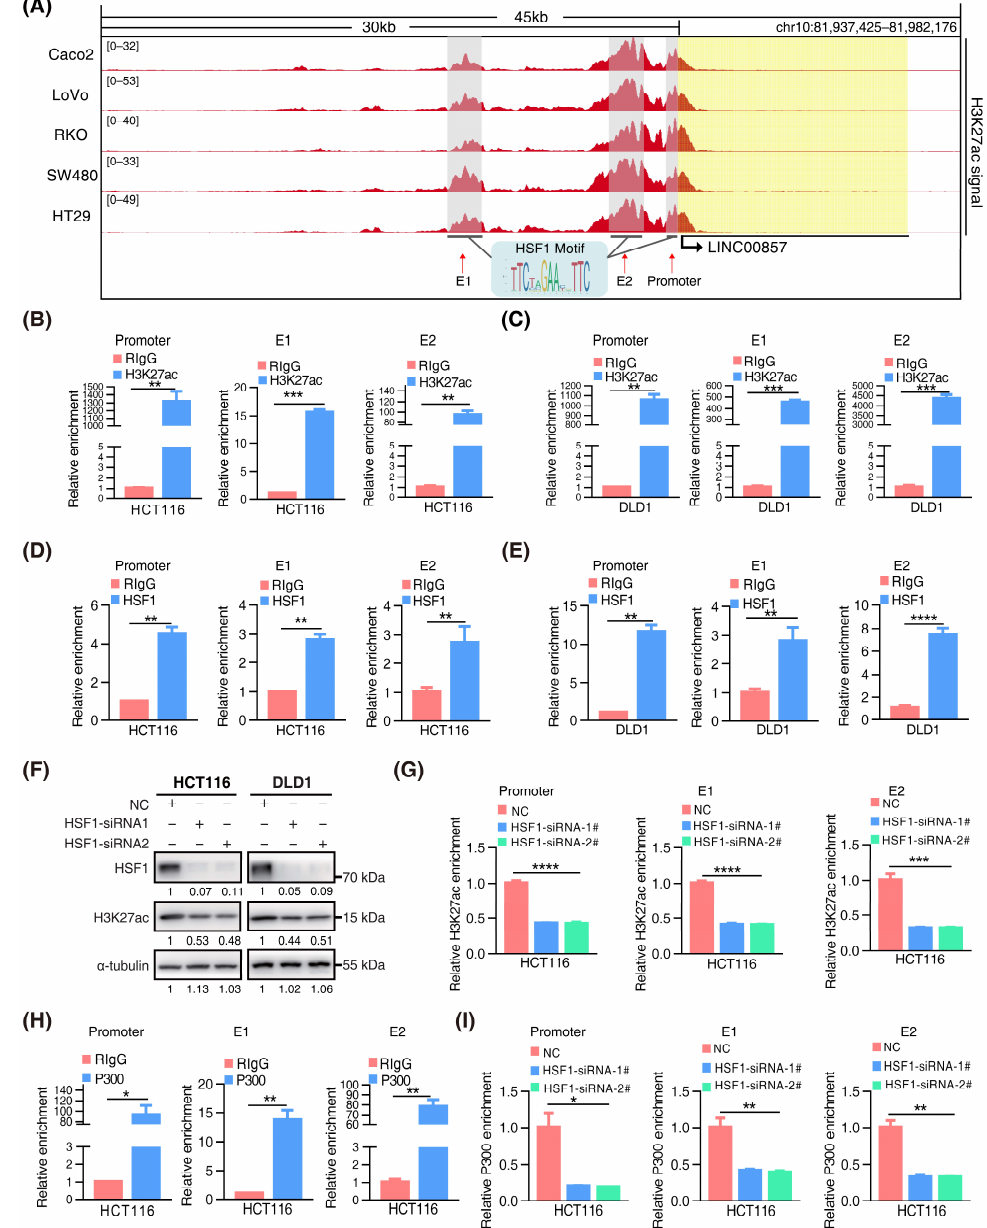
Figure 3. HSF1 activates the transcription of LINC00857 via promoting its super-enhancer